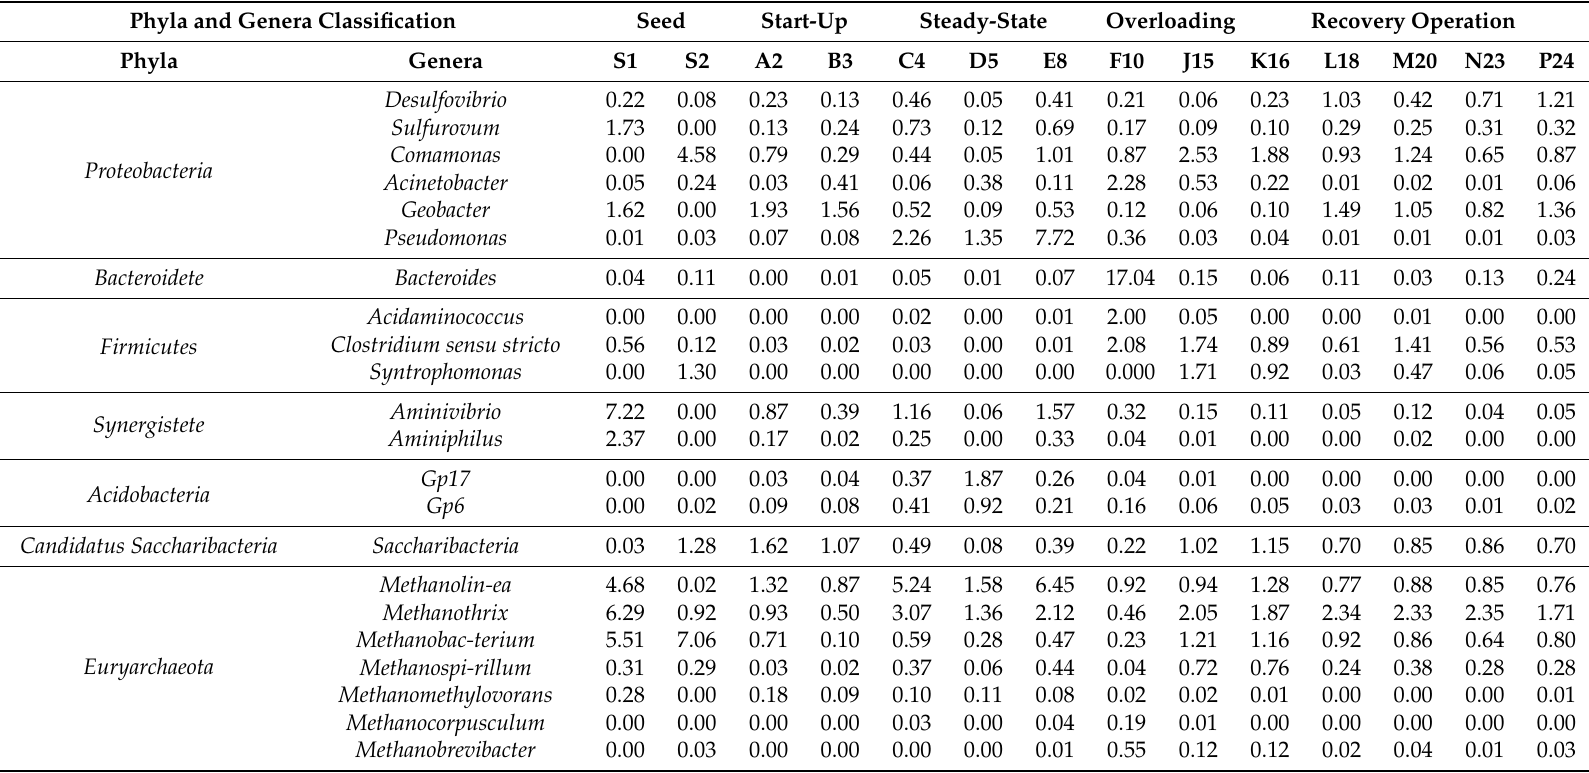
Table 2. The overall bacterial and archaeal community shift in the